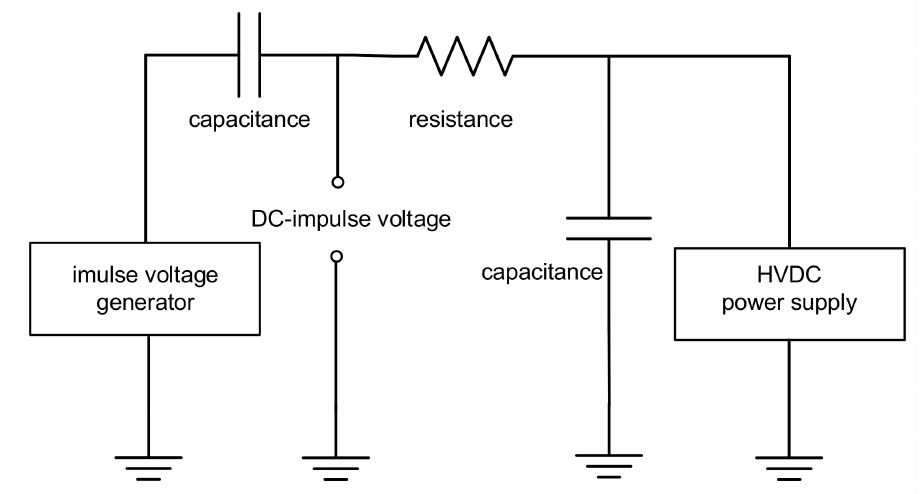
Figure A1. The equivalent circuit of the experimental configuration.